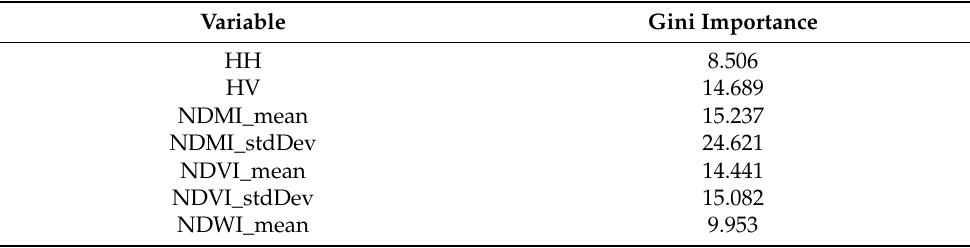
Table 6. Relative importance of the variables for the model classifying collapsed and not-collapsed pixels for Rakhine mangroves.